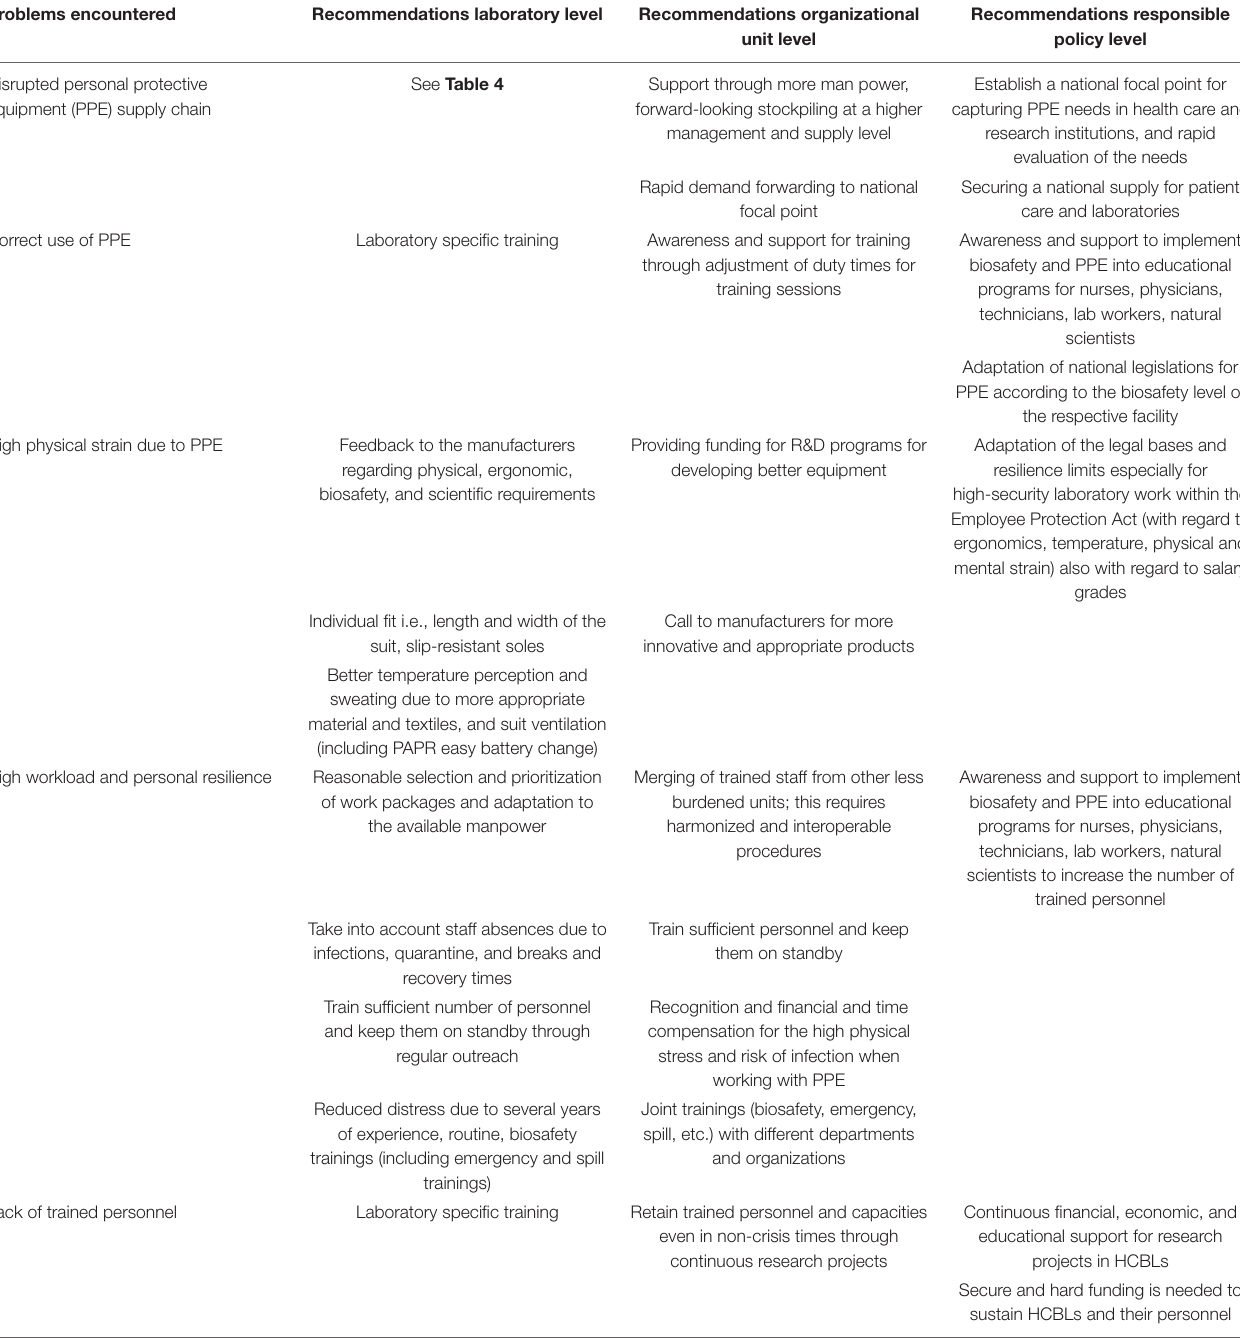
TABLE 4 | Key lessons learned from BSL-3 environment, recommendations and policy implications. Problems